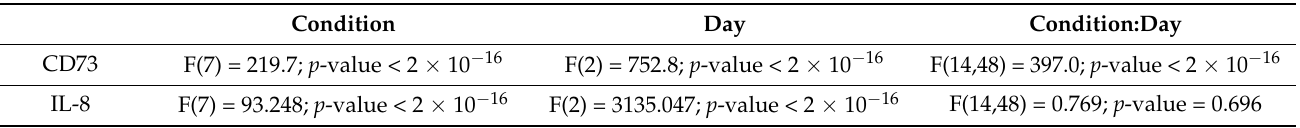
Table 5. Test statistics for Two-Way ANOVA testing for qPCR